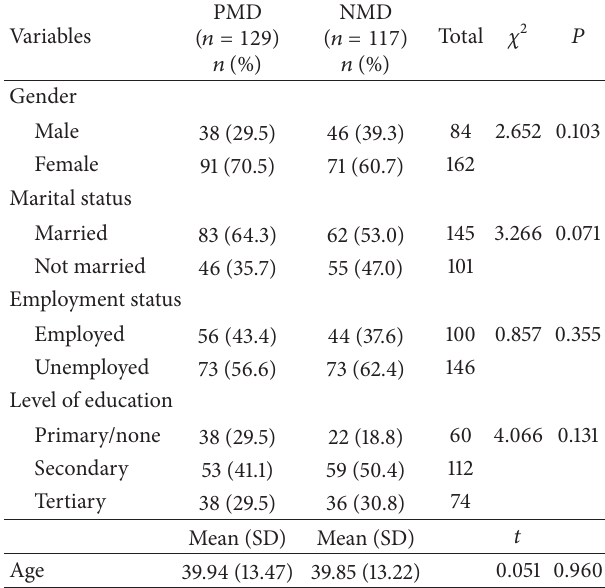
Table 1: Socio-demographic characteristics of the participants. Table 2: Prevalence of symptoms of depression in patients with PMD versus NMD.